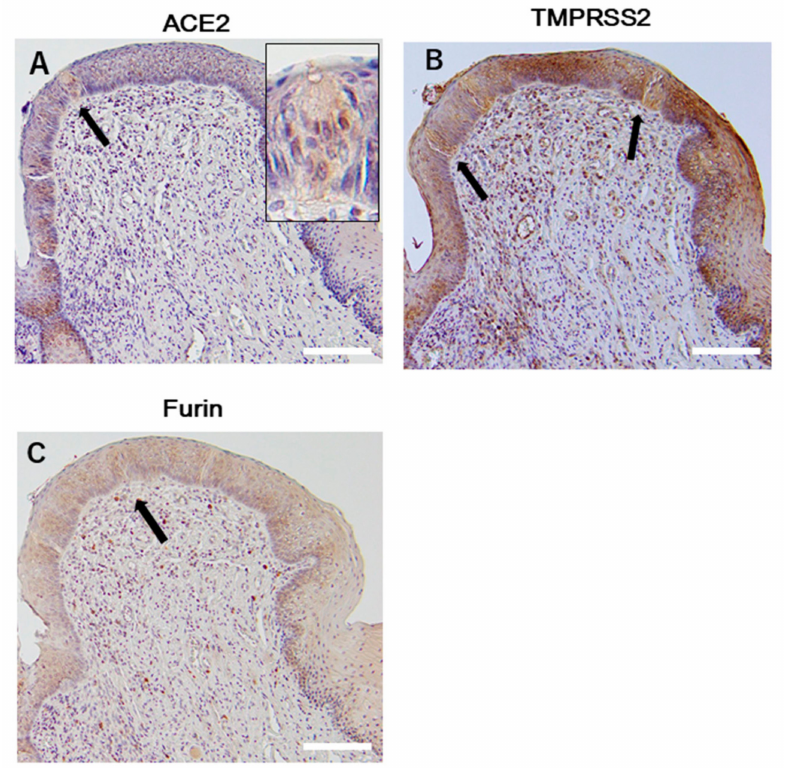
Figure 2. The fungiform papilla of the tongue epithelium. Immunohistochemical staining of ACE2 ( A ), TMPRSS2 ( B ), and furin ( C ) in the tongue epithelium, including the taste buds. High magnification image showing ACE2-positive taste cells in the inset. The arrows indicate the taste bud cells. Scale bar = 100 µ m. ACE2, angiotensin-converting enzyme 2; TMPRSS2, transmembrane protease serine